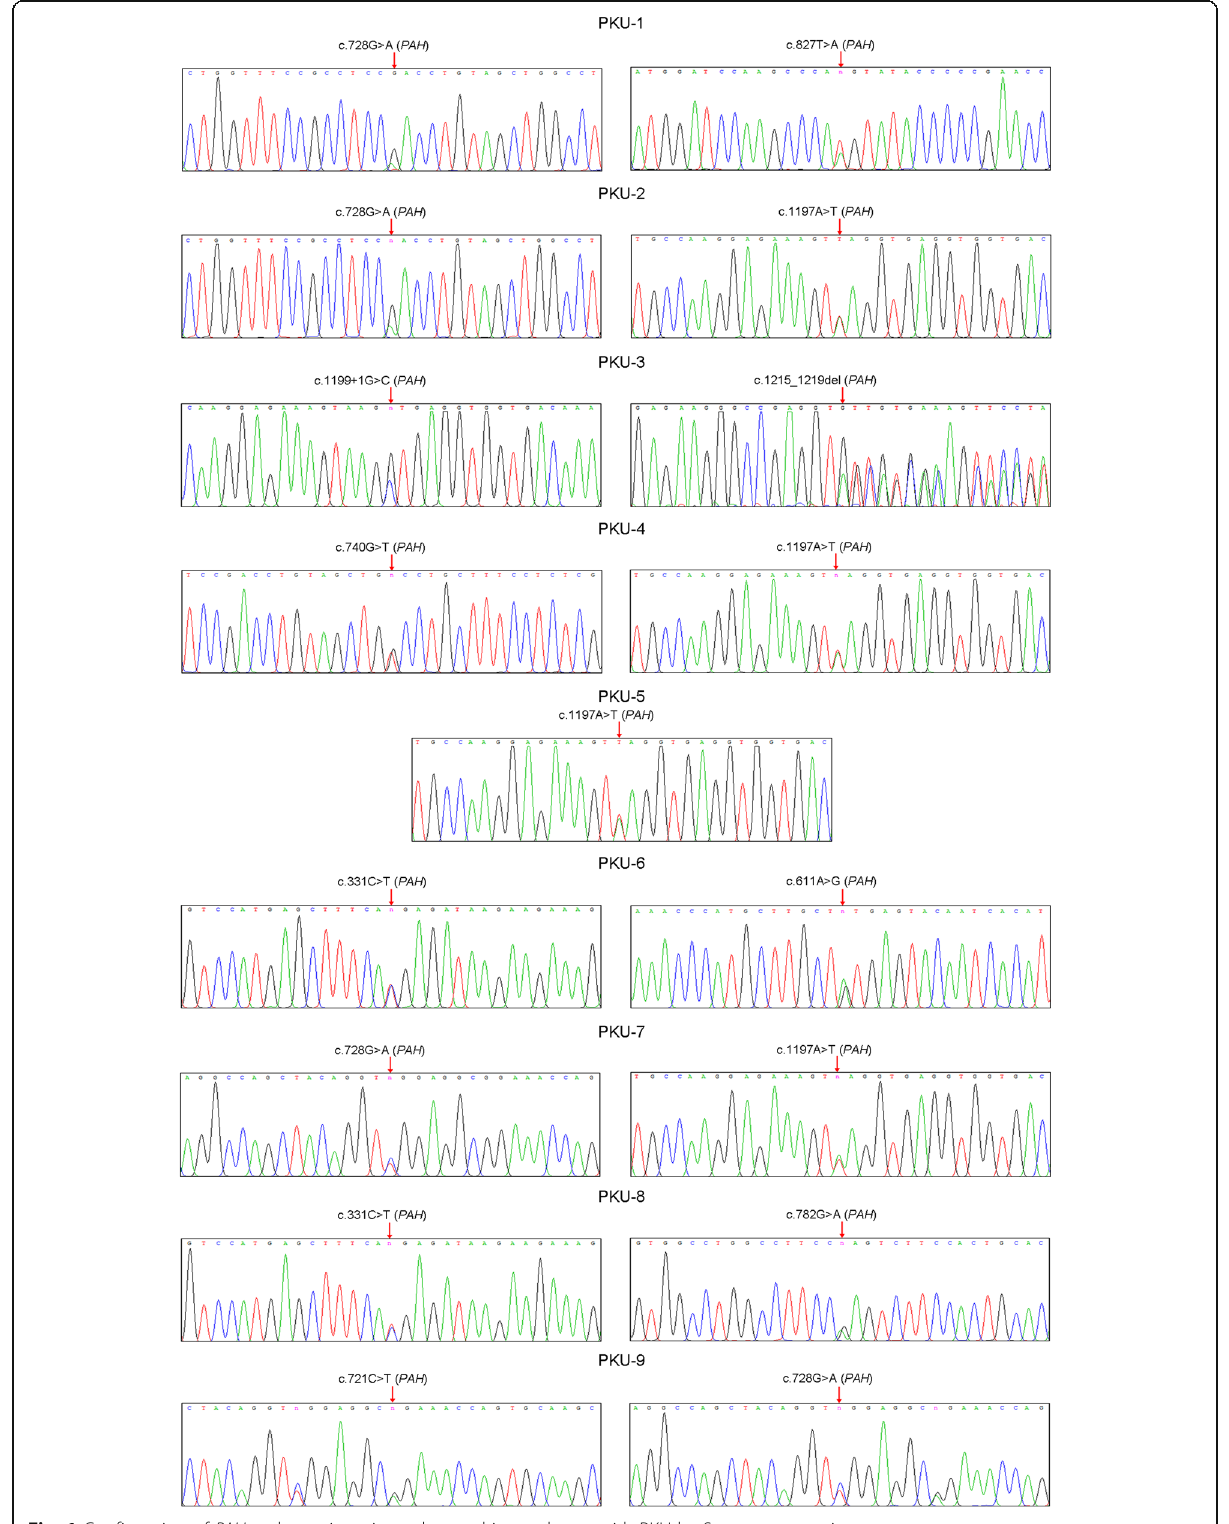
Fig. 1 Confirmation of PAH pathogenic variants detected in newborns with PKU by Sanger